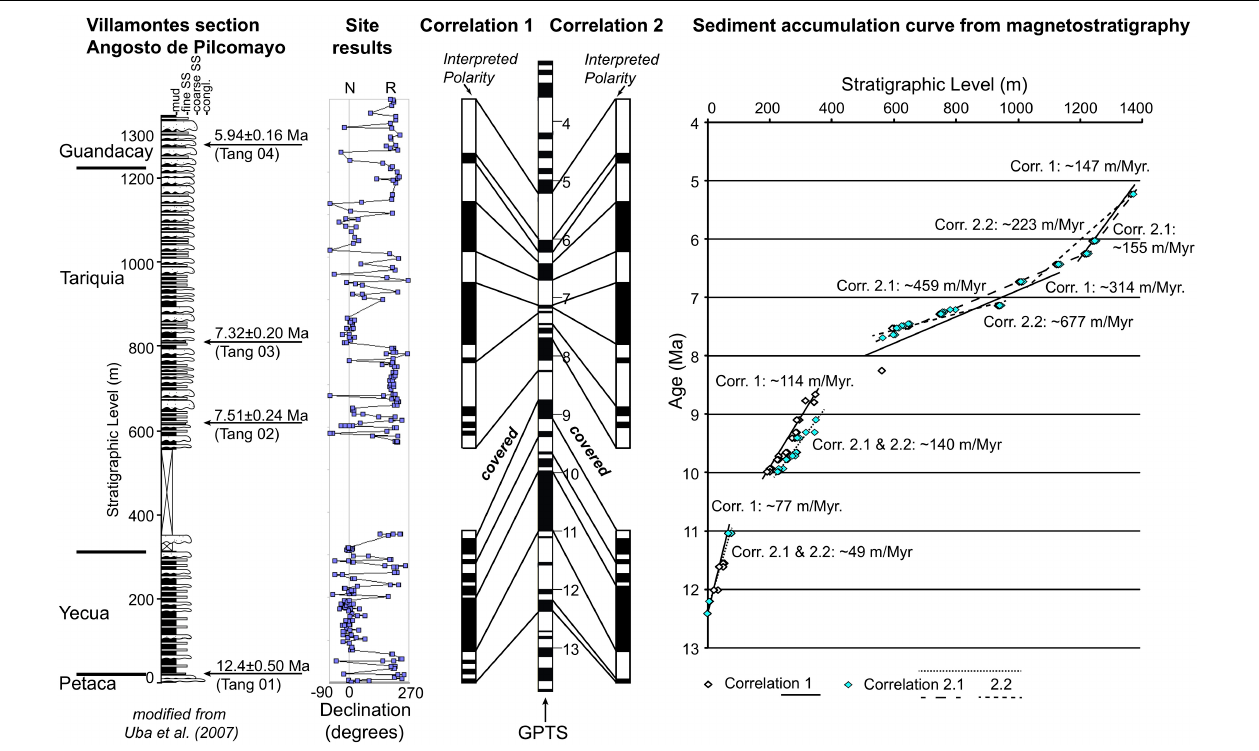
FIGURE 2 | Synthesis of magnetostratigraphic results. On the left, stratigraphic section geochronologic results from U-Pb geochronology at four positions (Uba et al., 2007) in the Angosto del Pilcomayo section near Villamontes, Bolivia. Site results from magnetostratigraphic investigation, showing the tilt-corrected declination of the primary magnetization vector determined for specimens at each site. N denotes normal polarity with a declination of 0 ◦ , and R denotes reversed polarity with a declination of 180 ◦ . Two possible interpreted polarity results are correlated with the Global Polarity Time Scale, pinned by the geochronologic ages shown. The ages and stratigraphic levels of the chrons in each correlation are plotted to define sediment accumulation curves. Correlation 1 is shown with white symbols, and average sediment accumulation rates are shown as linear interpolations (undecompacted). Correlation 2 is shown with light blue symbols. Two slightly different average sediment accumulation rates are shown, resulting in correlations 2.1 and